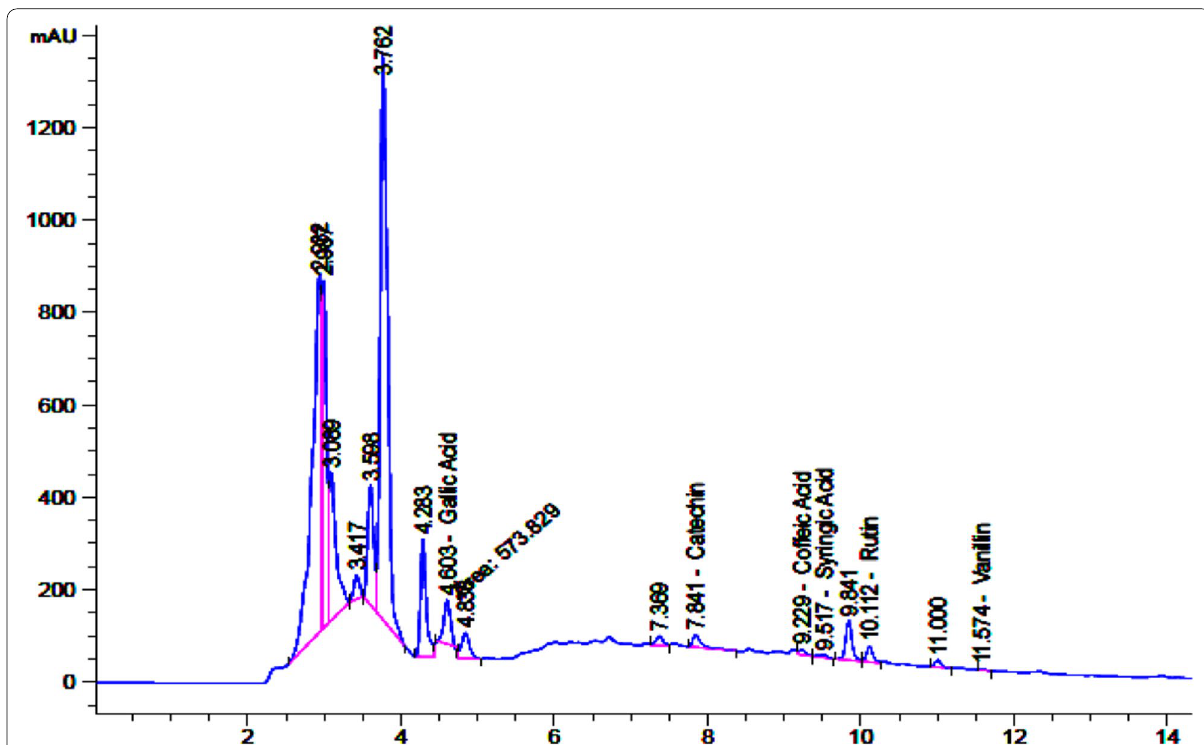
Table 1 The antagonistic effect of P. columbinus extract in alleviating the toxic effect of CTX on body weight, ovary, and uterine weights of rats Groups